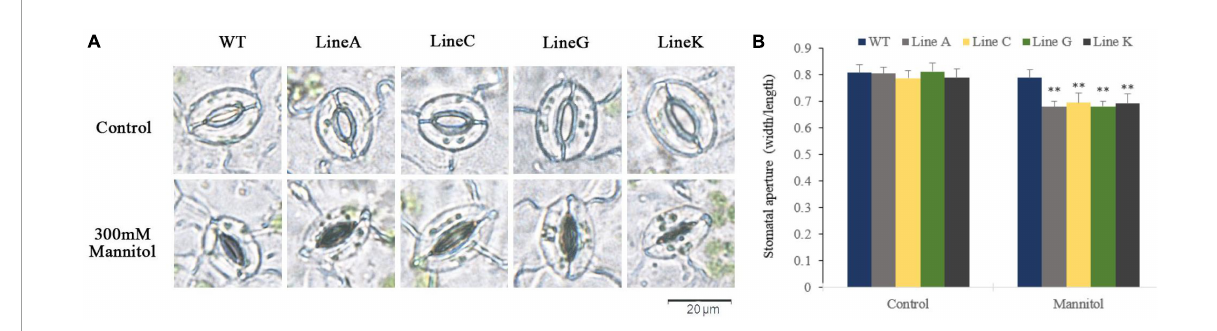
FIGURE7 Measurements of the stomatal aperture. (A) Microscopy observation of stomatal closure of WT and transgenic lines without (control) and with mannitol treatment (300 mM). (B) Measurement of stomatal aperture for transgenic and WT plants. Data are presented as mean and SD values of three independent experiments. Asterisks indicated significant difference ( ∗∗ textitP < 0.01, by Student’s t -test) comparing to